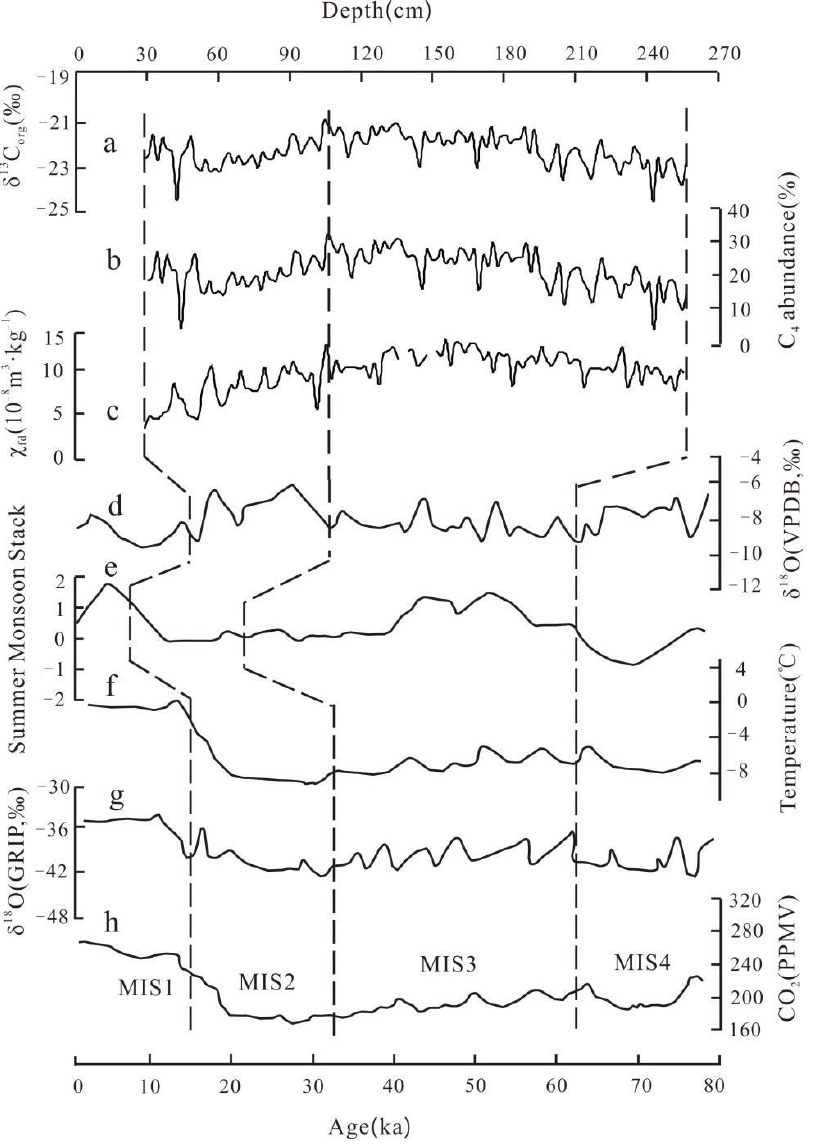
Figure 6. ( a ) The δ 13 C org record of the CQS section; ( b ) C 4 abundance in the CQS section; ( c ) χ fd of the CQS section; ( d ) oxygen isotope records from Chinese stalagmite [53]; ( e ) the East Asian summer monsoon records [54]; ( f ) ocean temperature records from Antarctica Dome C ice cores [6,55]; ( g ) GRIP marine oxygen isotope records [56]; ( h ) atmospheric CO 2 concentration recorded by Antarctic ice cores [57].